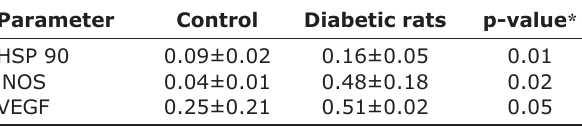
Table-1: Expression of HSP 90, iNOS, and VEGF in skin of alloxan-induced diabetic rats (values are expressed in mean±SD based on descriptive analysis using pixel count on Photoshop of immunohistochemistry images).